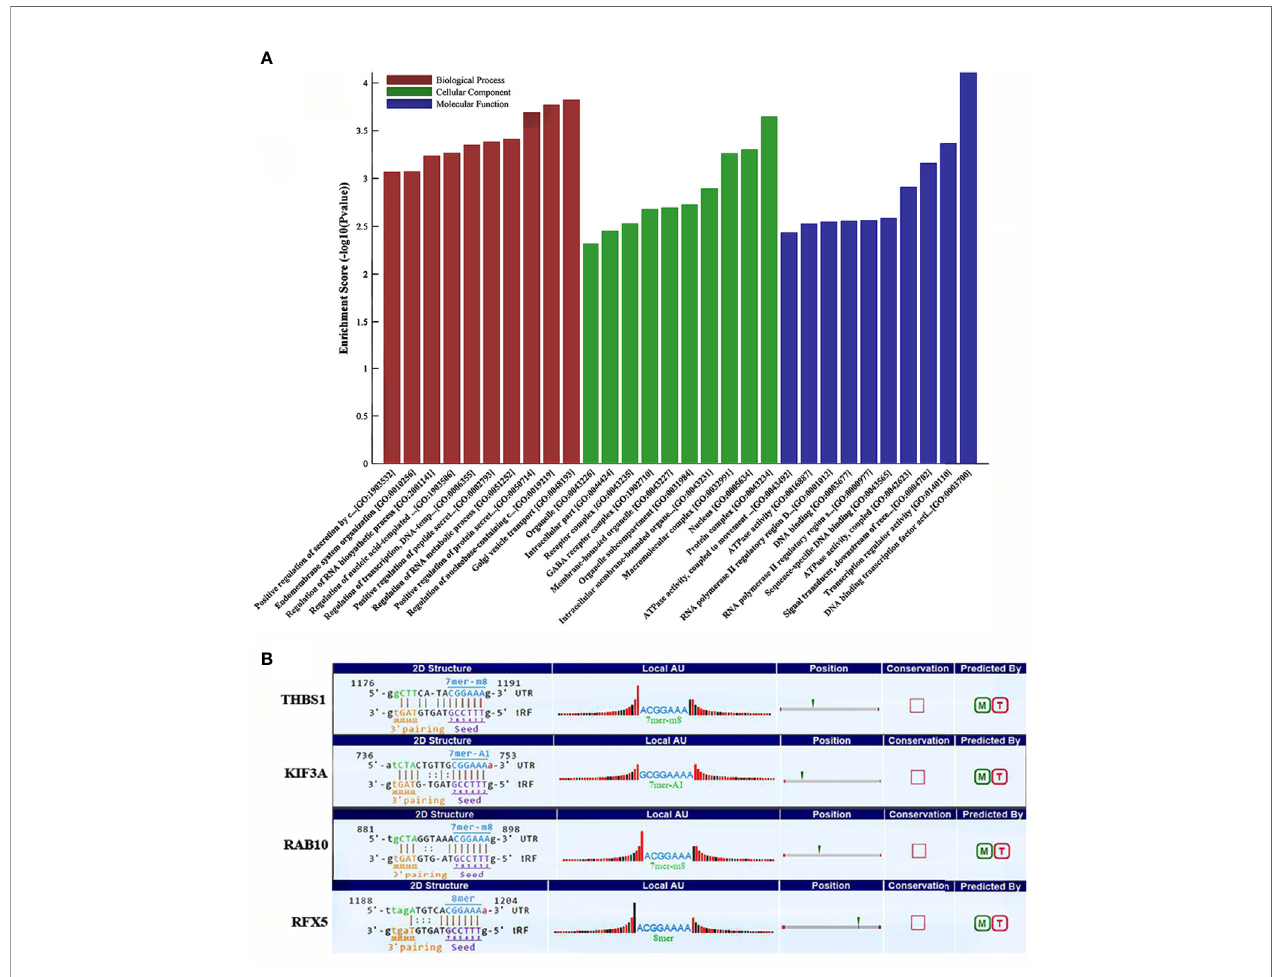
FIGURE 4 | GO and KEGG enrichment analysis of tRF-17-79MP9PP target genes. (A) GO analysis of the DEGs-tRF-17-79MP9PP target genes enriched in biological process (BP), Cellular component (CC) and Molecular function (MF). (B) The 3 ’ UTR area of the four candidate genes ( THBS1 , KIF3A , RAB10 , RFX5 ) combined with